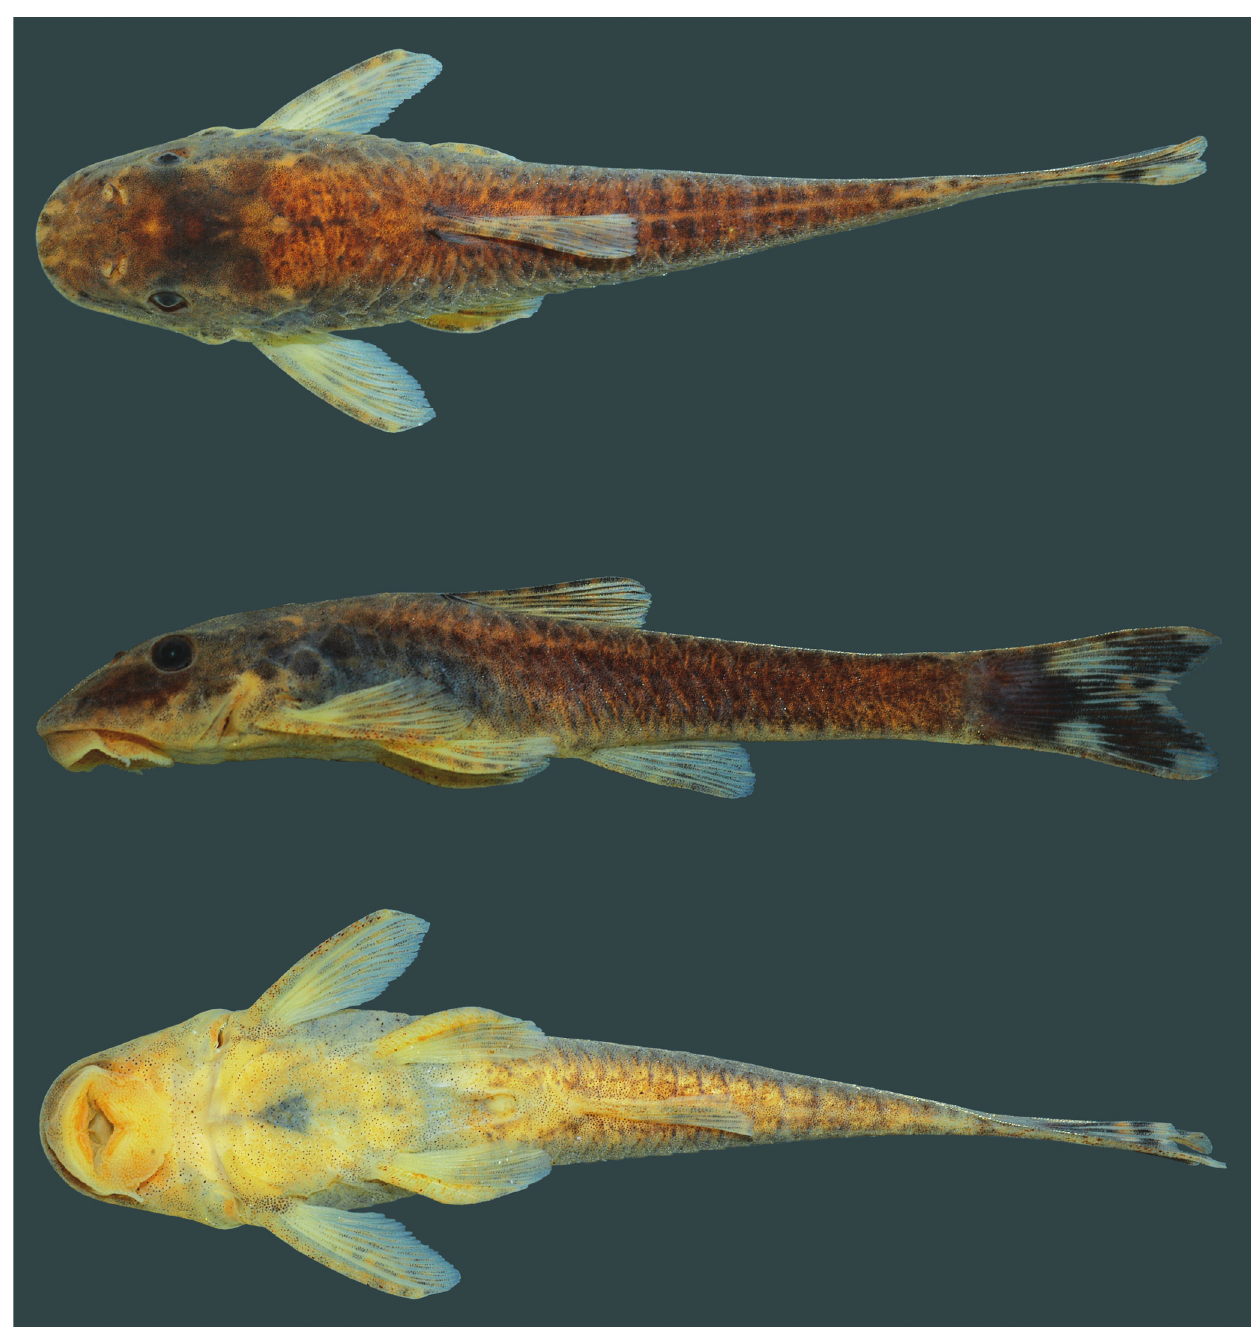
Fig. 1. Microlepidogaster dimorpha , holotype, DZSJRP 10543, 37.6 mm SL, female, riacho Grotão at Fazenda Nossa